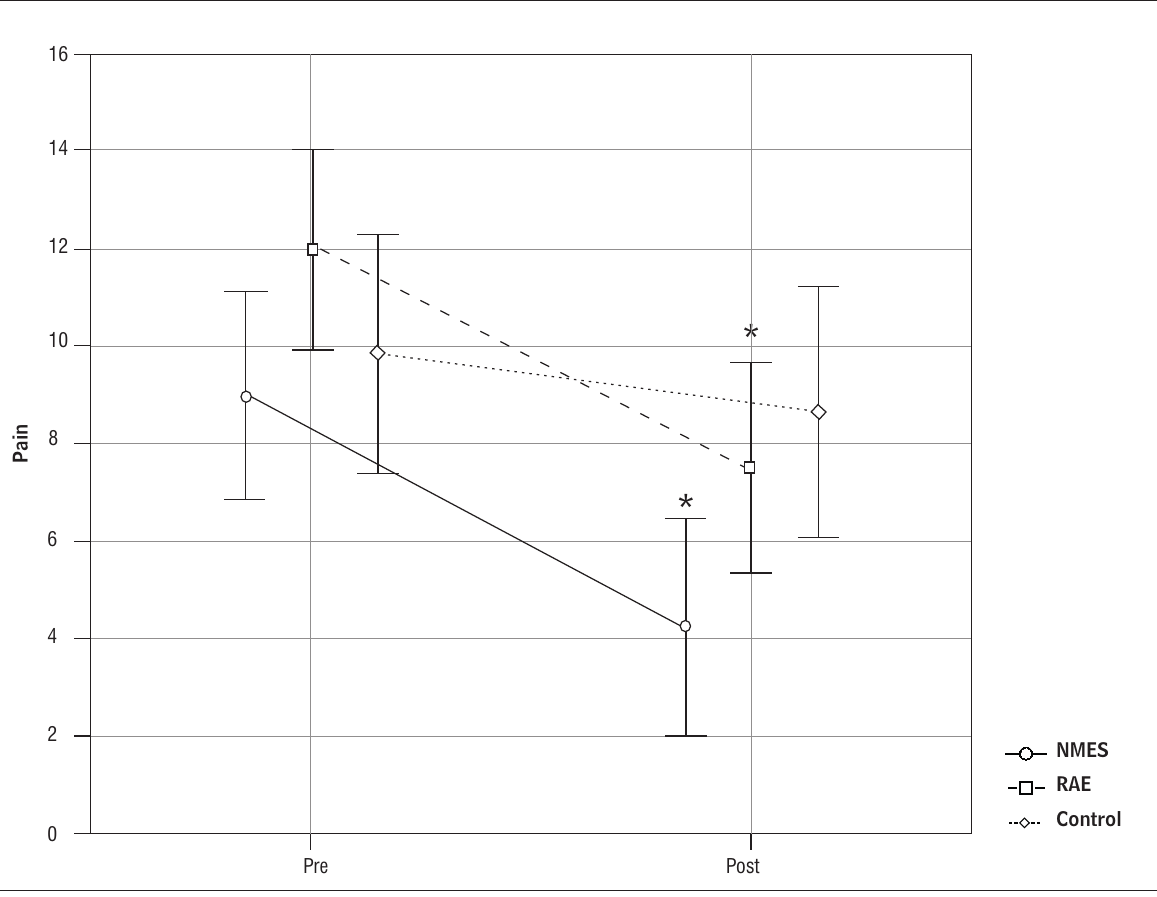
Graph 2 - Knee pain before and after the 24-session program for neuromuscular electrical stimulation (NMES), resistance against exercise (RAE), and control (bars represent a confidence interval of 95 % ) Legend: * = P < 0.05 intra-group. Source: Research